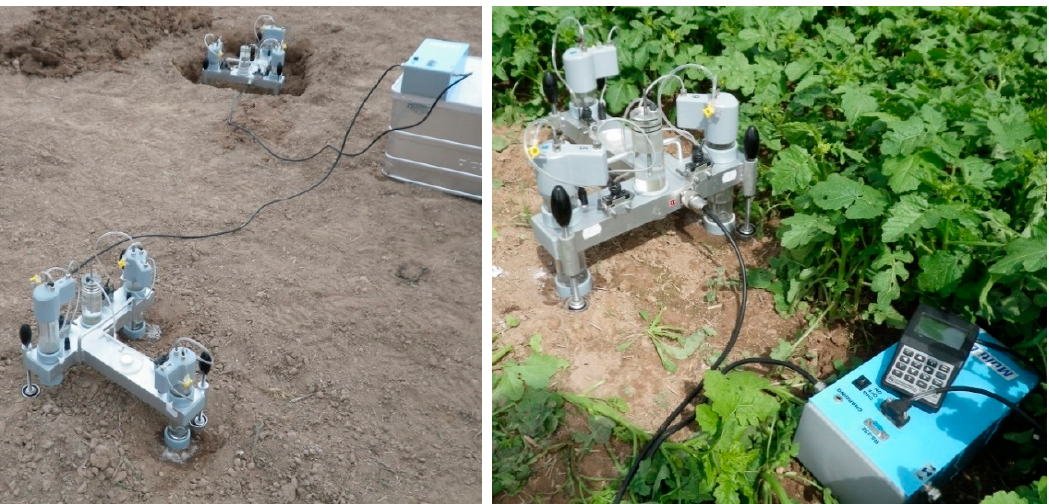
Figure 2. Scheme of one triplet of the MultiDisk infiltrometer modules held by an aluminum frame viewed, ( a ) from the top and ( b ) from the side (View A). Note that one apparatus-MultiDisk-consists of two identical triplets.